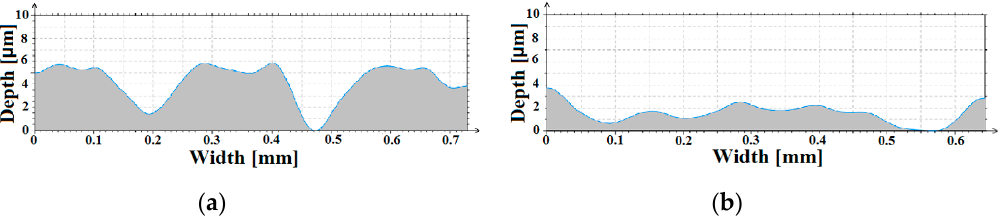
Figure 10. Profiles of wear paths; steel equivalent 17Ni4CrMo (i.e., CSN 41 6720); performed by Talysurf CLI 1000. ( a ) Profile of wear path of non-nitrided specimen; vz. 61; R = 26 mm; 500 rpm; 18 min; F = 20 N; T = 80 °C — on left. ( b ) Profile of wear path of nitrided specimen; vz. 2-2; R = 26 mm; 750 rpm; 18 min; F = 20 N; T = 80 °C — on right.